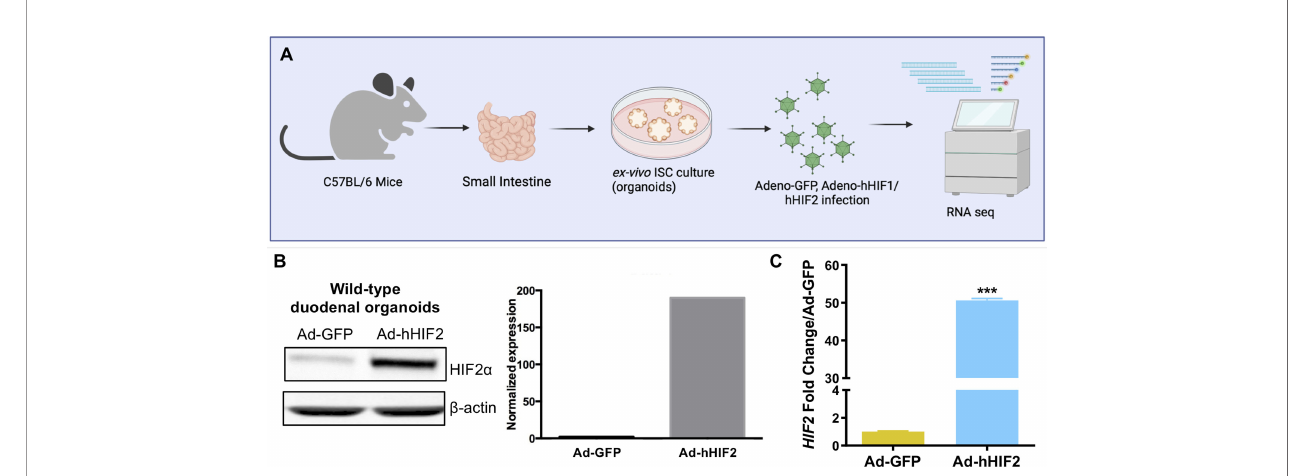
FIGURE 1 | HIF2 overexpression in ISC-enriched duodenal organoid cultures. (A) Experimental design to generate 3D murine small intestinal organoid model system. Duodenal organoids were transduced with Adenovirus-human HIF1 (Ad-hHIF1), Ad-hHIF2, or Ad-GFP as control, and then RNA sequencing was performed. (B) Validation of adenovirus-mediated gene transfer by Western blot ( left ) and its quanti fi cation ( right ). (C) Validation of adenovirus-mediated gene transfer by qRT- PCR. All error bars represent mean ± SEM. ***P < 0.001, by Student ’ s t